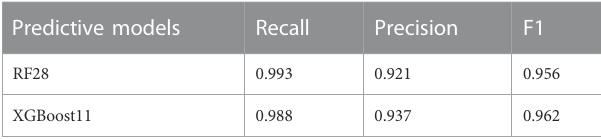
TABLE 4 Result of the RF28 and XGBoost11 predictive models. Predictive models